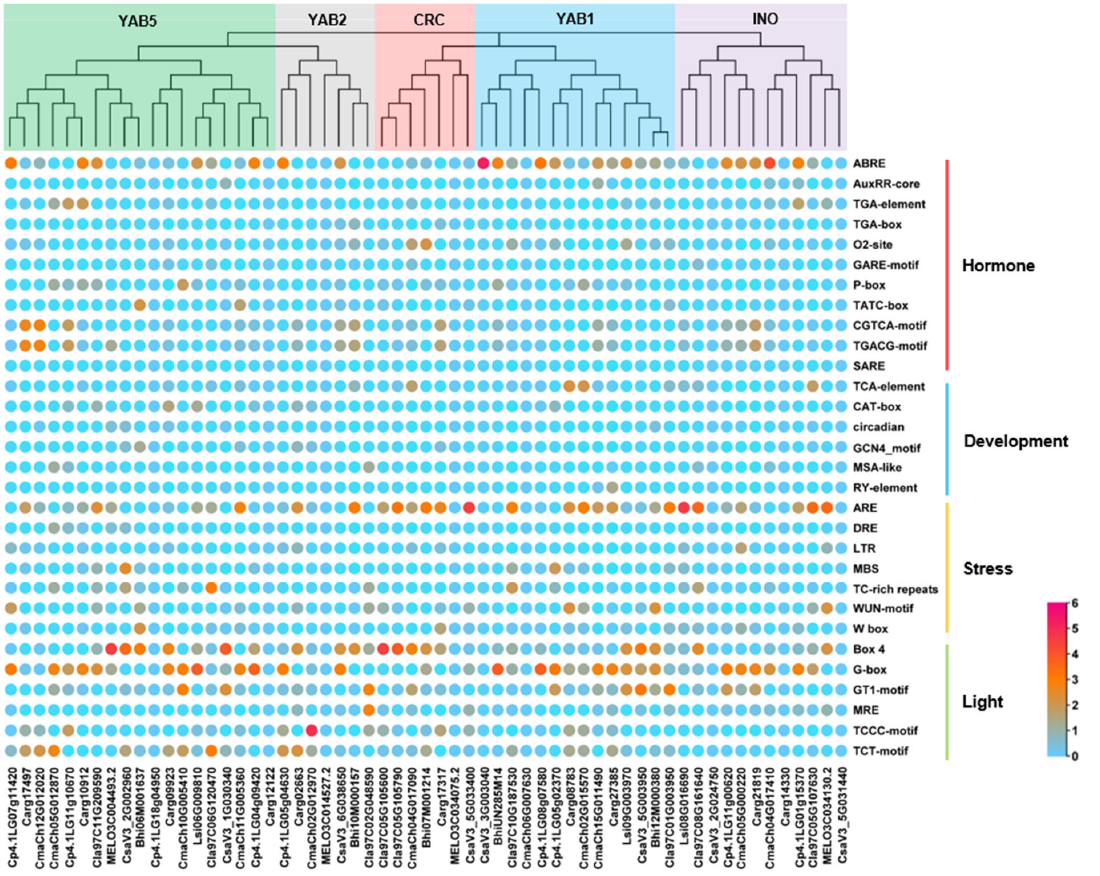
Figure 5. The cis ‐ acting elements analysis of 59 YABBY genes promoters across Cucurbitaceae. The Figure 5. The cis -acting elements analysis of 59 YABBY genes promoters across Cucurbitaceae. The numbers of cis ‐ acting elements are shown in a heatmap. numbers of cis -acting elements are shown in a